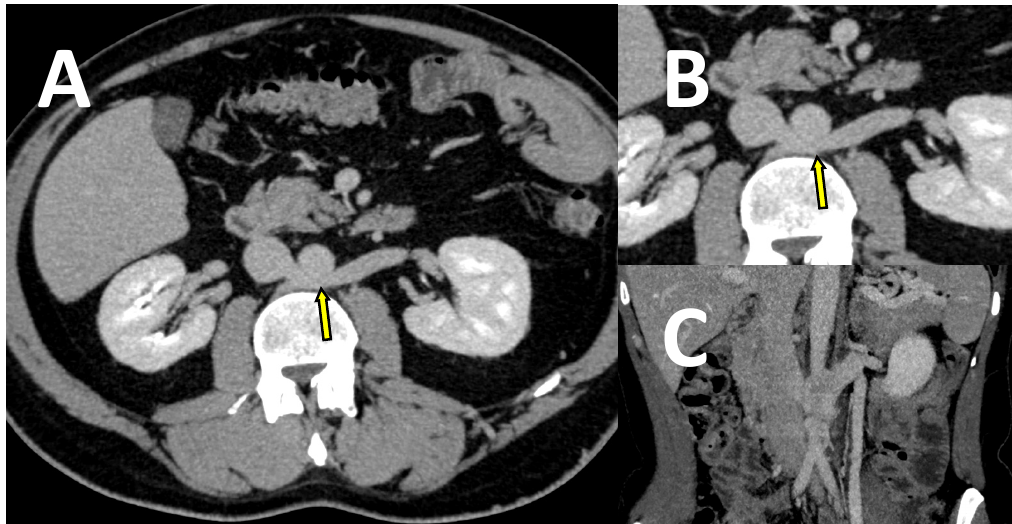
Figure 4. The images of a CT-V scan in a patient with LRV entrapment (“nutcracker” syndrome). LRV (marked with ar- rows) is compressed between the aorta and superior mesenteric artery (SMA), as shown on the transverse plane—whole image ( A ), enlarged image ( B ), and on the sagittal plane ( C ).